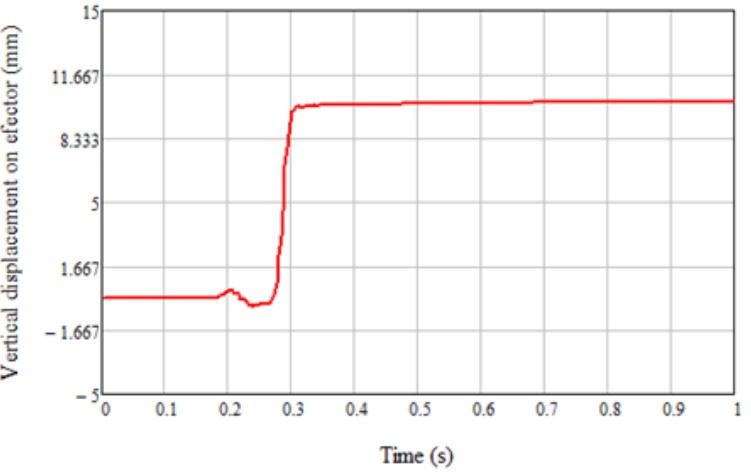
Figure 24. Vertical displacement variations for the 5 kg mass. The average values of the displacements were calculated in the time interval (0.72, 0.8) s.